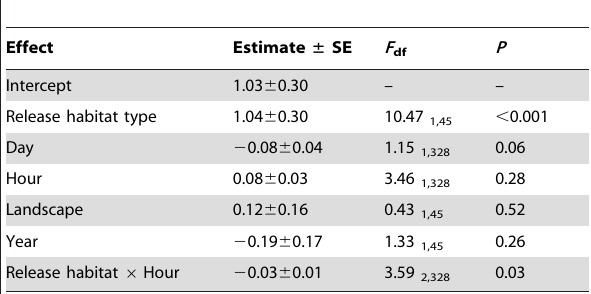
Table 4. Influence of factors on migrant habitat